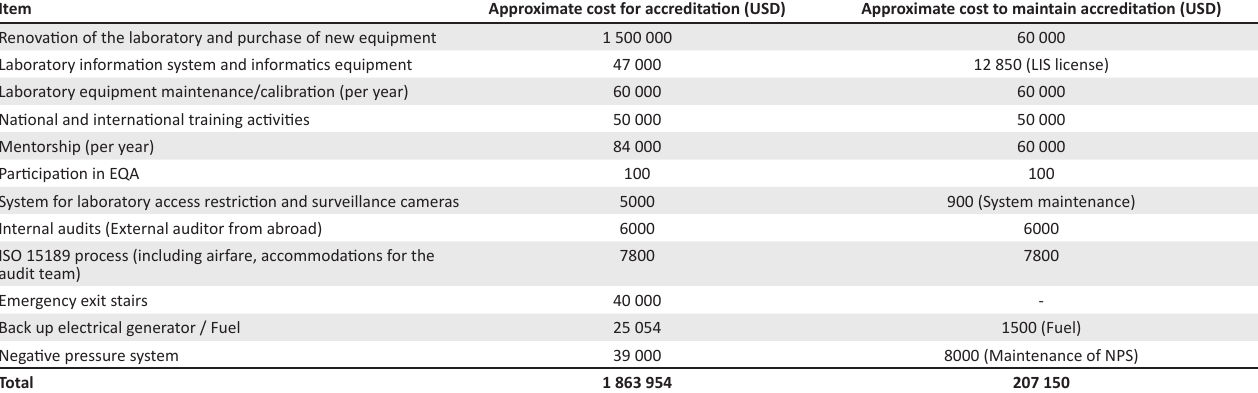
TABLE 3: Approximate costs of National Tuberculosis Reference Laboratory accreditation, Mozambique, 2011–2013.